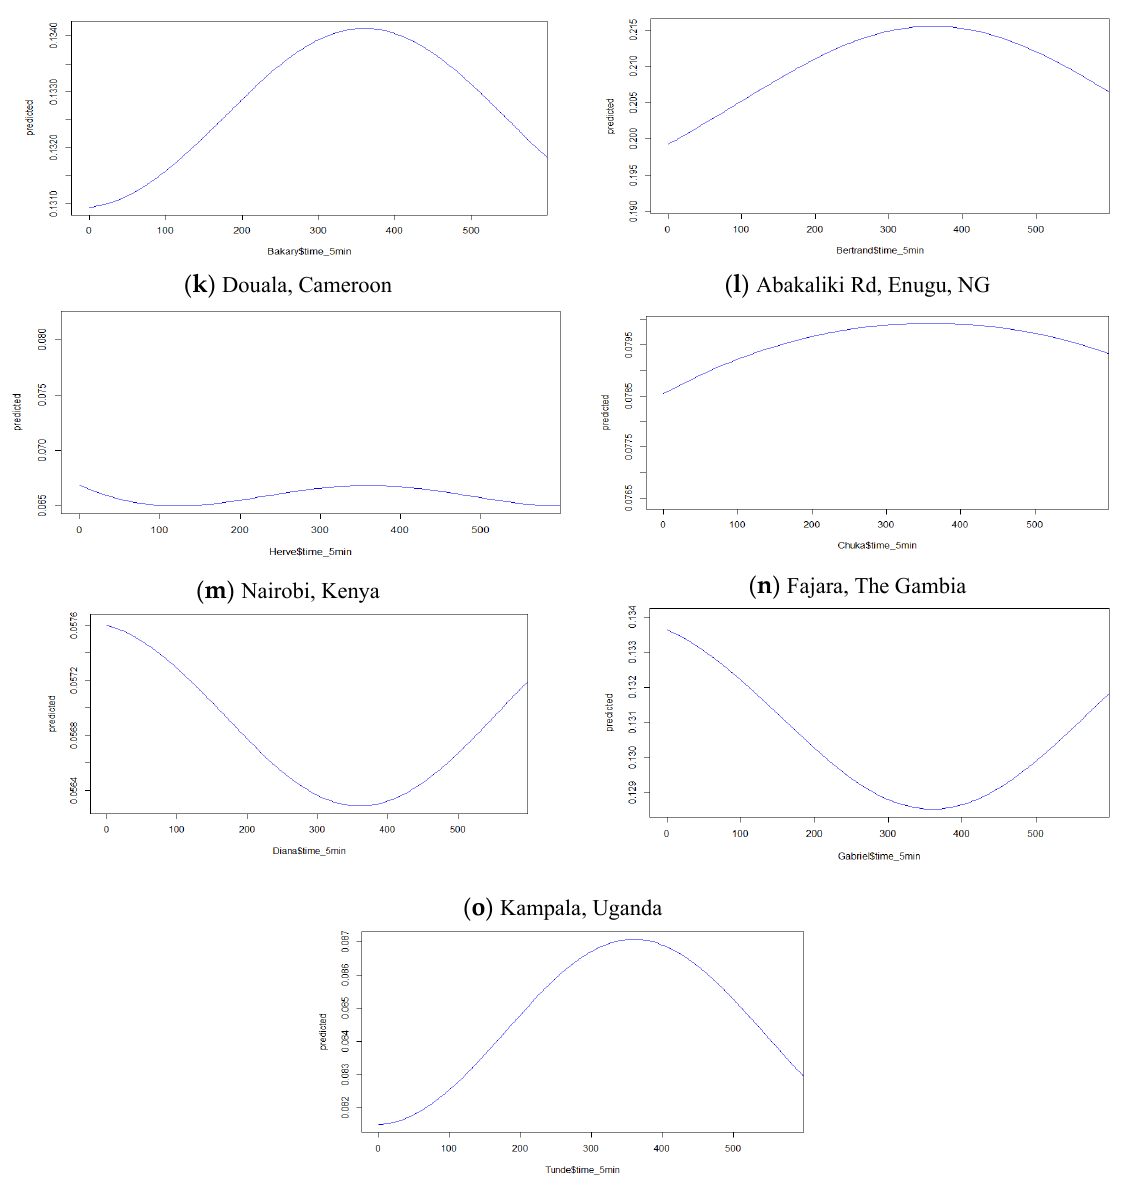
Figure 6. Harmonic regression tracings for each study site. Harmonic regression plots showing the temporal changes in PM 2.5 pollution spikes and throughs at all sampling sites ( a – o ). X-axis bears the time in minutes while the Y-axis shows the predicted PM 2.5 values.